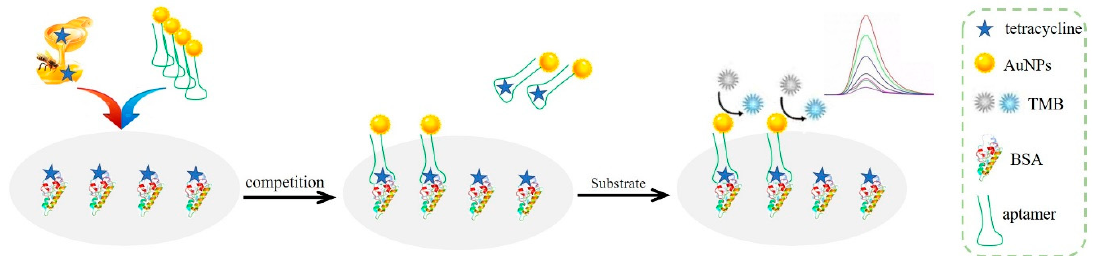
Figure 1. Illustration of the proposed gold nanoparticle-linked aptamer assay.